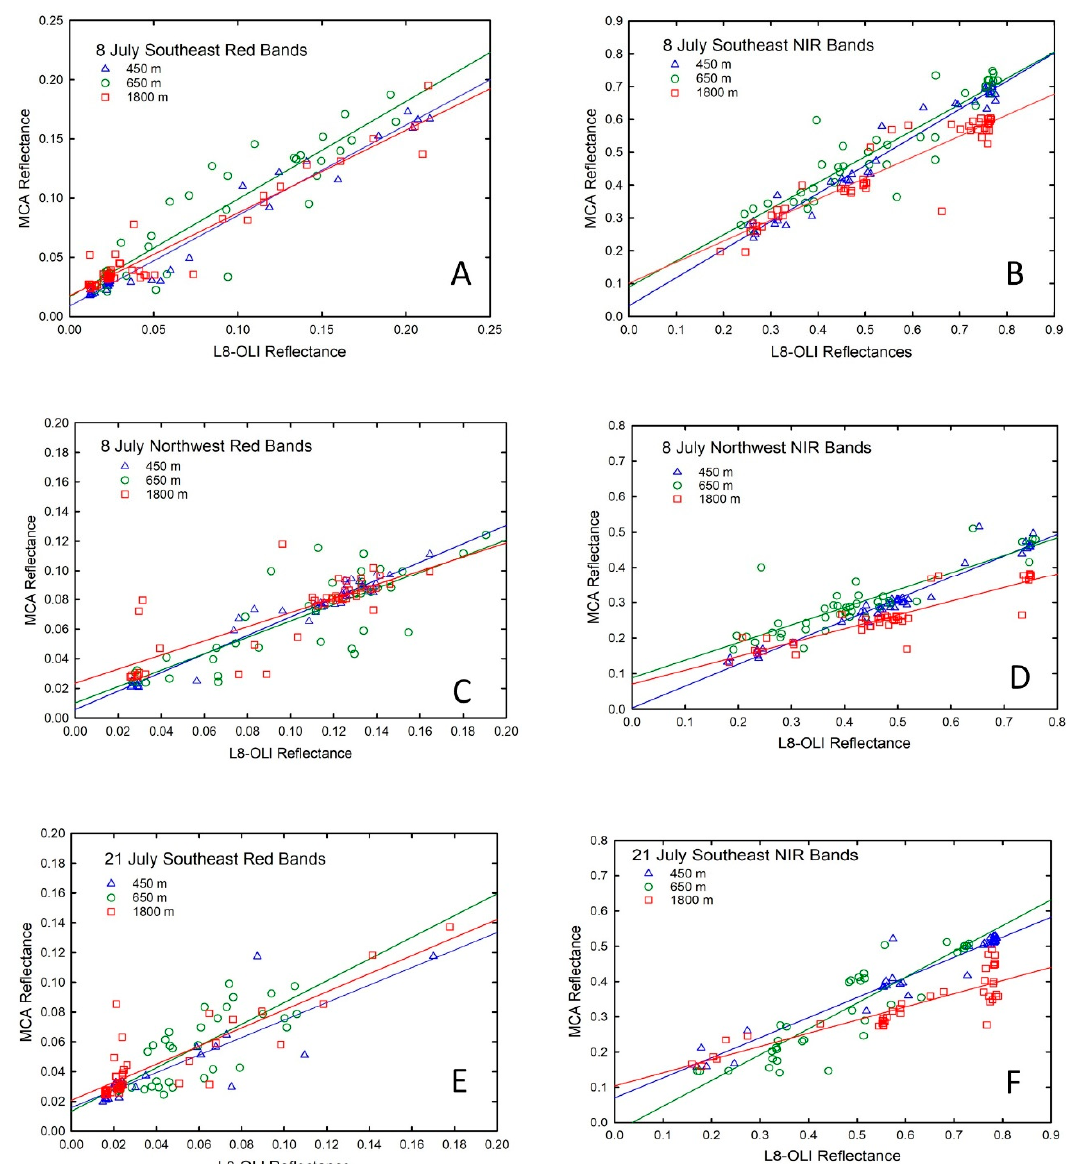
Figure 6. Comparison of three flight altitudes AGL for: 8 July southeast flight lines ( A ) red bands and Figure 6. ( B ) NIR bands; 8 July northwest flight lines ( C ) red bands and ( D ) NIR bands; and 21 July southeast flight lines ( E ) red bands and ( F ) NIR